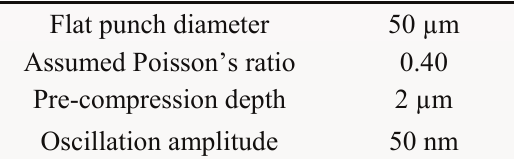
Table 3. Parameters used for dynamic mechanical analysis